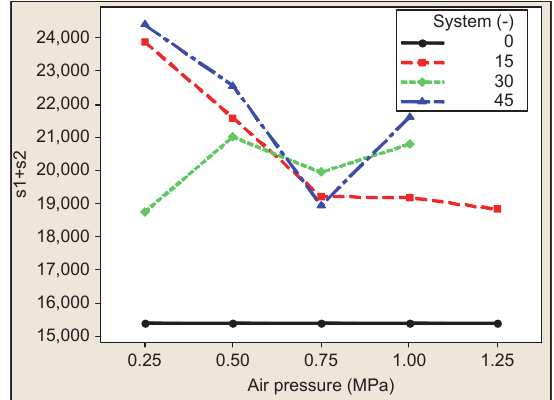
Figure 9 Total number of hairs shorter than 3